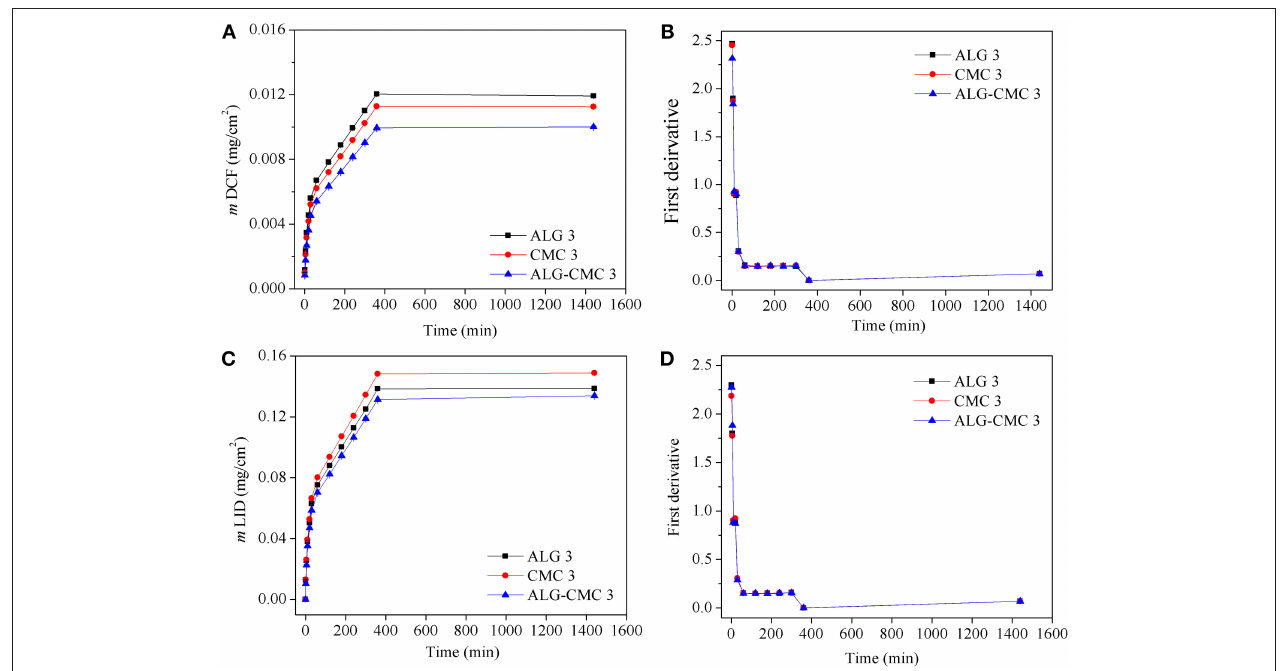
FIGURE 4 | In vitro release studies of DCF and LID from the spin-coated multi-layers of alginate (ALG 3), carboxymethyl cellulose (CMC 3) and ALG-CMC 3 blend. Dissolution profiles of DCF (A) and LID (C) of mass change as a function of time. First derivative of the release data of DCF (B) and LID (D)